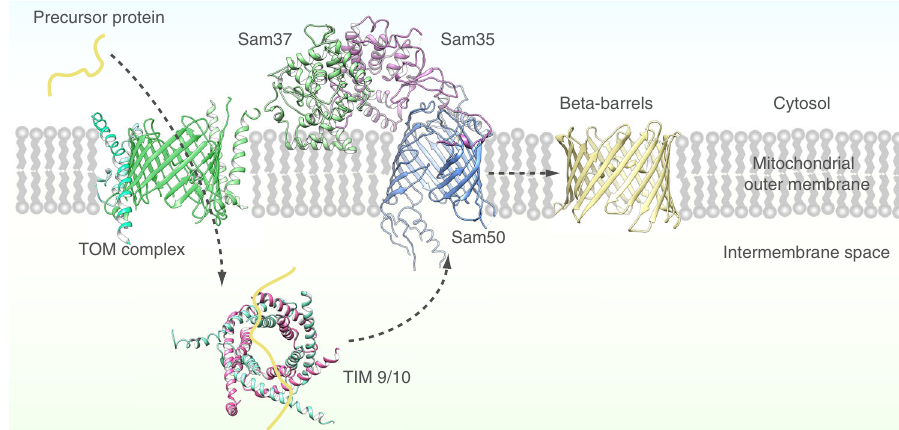
Fig. 1 Schematic of β -barrel outer membrane protein biogenesis in mitochondria. Mitochondrial outer membrane β -barrel proteins are synthesized in the cytosol (yellow), then imported into the intermembrane space of the mitochondria by the translocase of the outer membrane complex (TOM complex, green). Once in the intermembrane space, the precursor protein is bound by chaperone proteins (TIM9/10, magenta/cyan) and directed to the sorting and assembly machinery complex (SAM complex, blue/light green/orchid). The SAM complex facilitates outer membrane β -barrel precursor protein folding and insertion into the outer